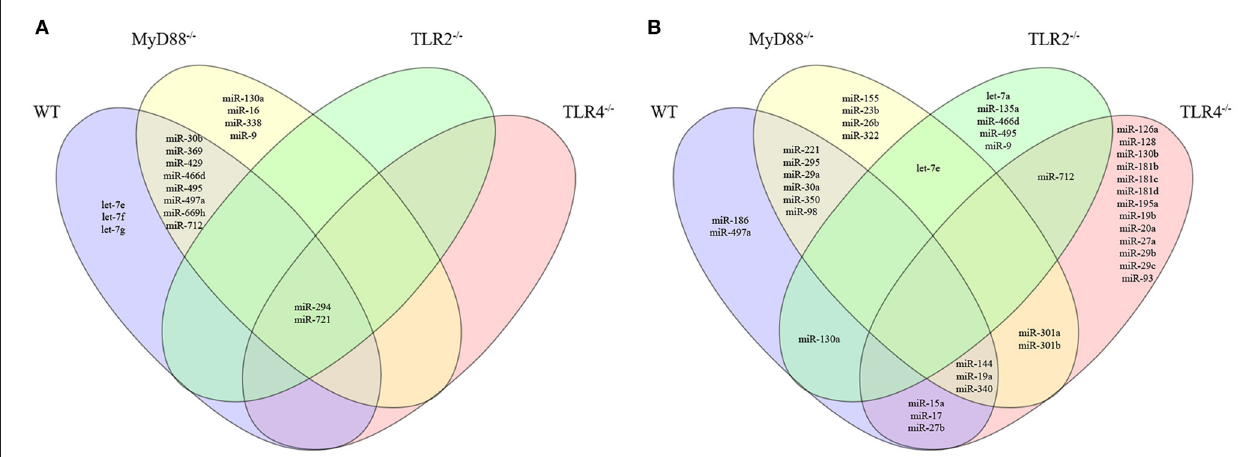
FIGURE 4 | Venn diagram depicting unique and common miRNAs that were significantly differentially expressed in macrophages from WT or MyD88, TLR2 and TLR4 null mice infected with L. amazonensis . The miRNA expression levels in infected WT (purple), MyD88 − / − (yellow), TLR2 − / − (green), or TLR4 − / − (red) macrophages were examined. The upregulated (A) and downregulated (B) miRNAs in each group were compared to uninfected macrophages. The relative up- and downregulation of miRNAs are presented as boundaries of 1.2 or − 1.2 of Fold Regulation, respectively. P -value <